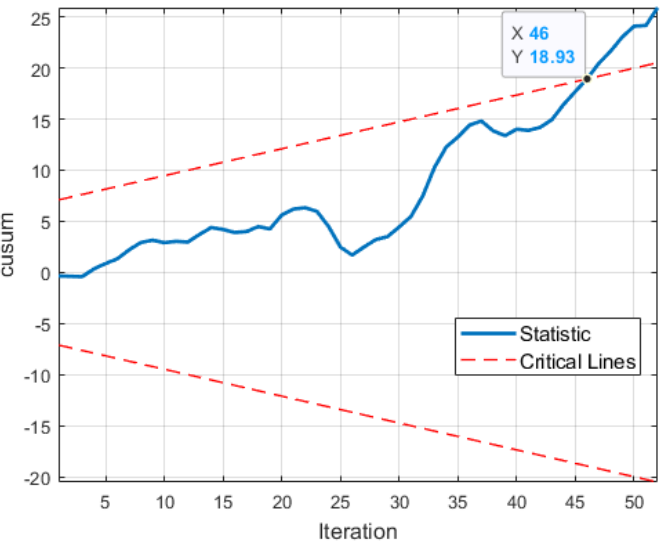
Figure 2. Structural change detection in the model for real gross national product using the CUSUM test.